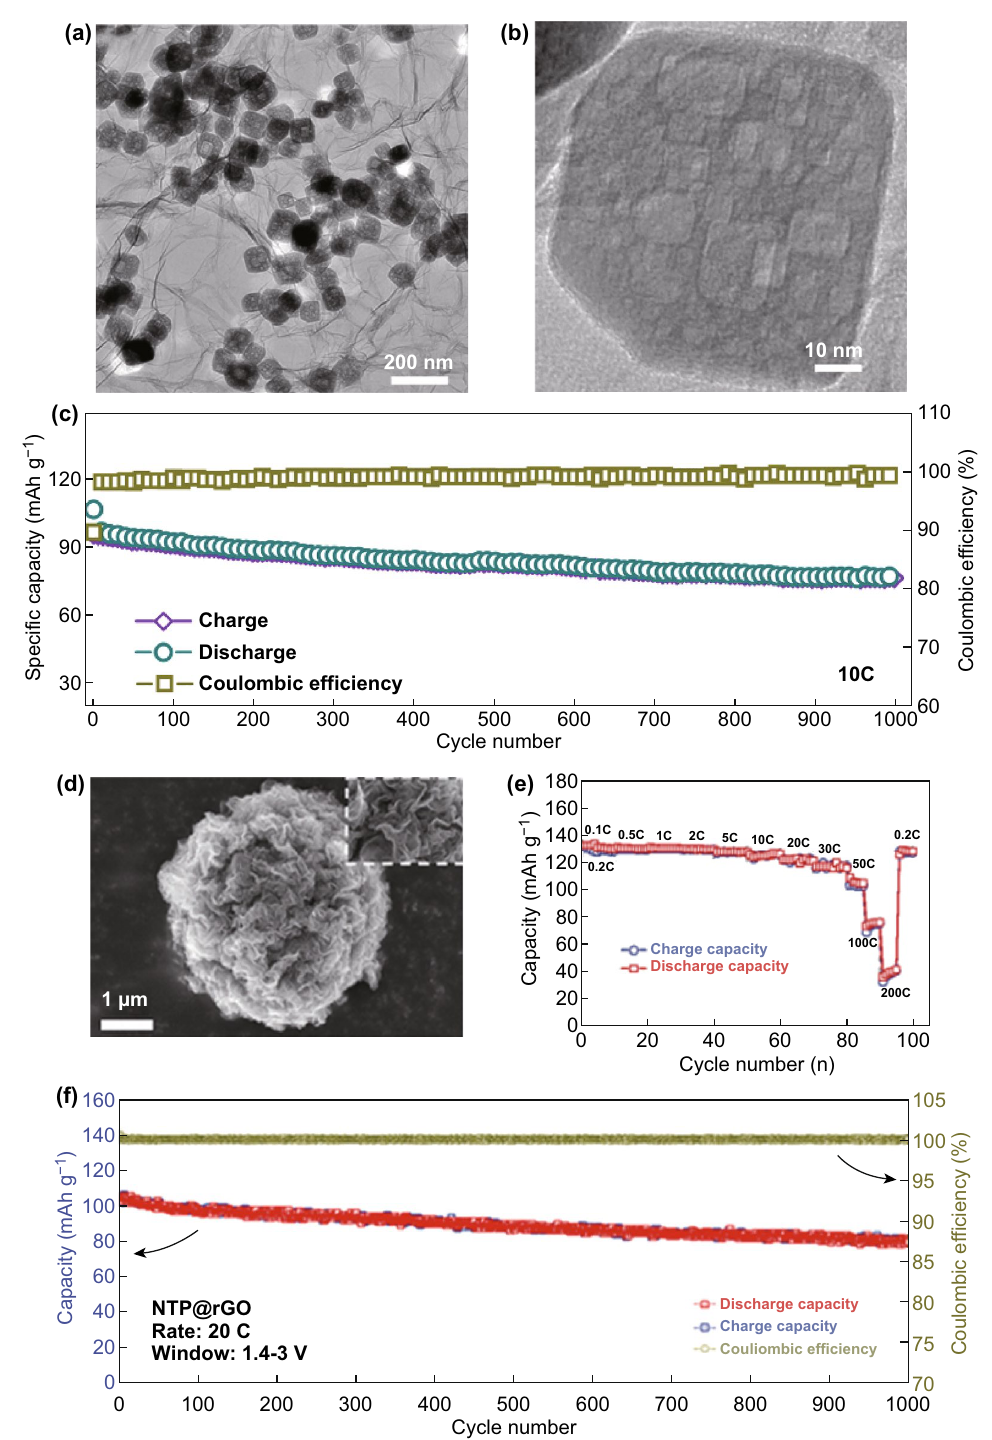
Fig. 6 a TEM and b HRTEM images of NTP ⊂ GN and c long cycling performance of the NTP ⊂ GN electrodes. Note that all the capacity val- ues for the NTP ⊂ GN electrodes are calculated on the basis of the mass of NTP, which is 65% of the whole electrodes including NTP, graphene, carbon black, and PVDF [45]. Copyright 2015, American Chemical Society. d SEM images showing a 3D graphene network obtained by remov- ing NaTi 2 (PO 4 ) 3 nanoparticles with HF solution. e Rate capability of the NTP@rGO electrode. f Long-term cycling performance of the NTP@ rGO electrode at a high current rate of 20 C over 1000 cycles in the voltage window 1.4–3.0 V [44]. Copyright 2016,